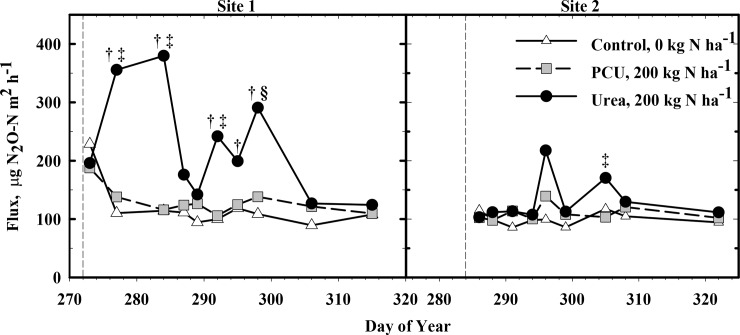
Nitrous oxide (N2O) flux measured on multiple individual days for Sites 1 and 2 from application of 0 (Control) and 200 kg N ha-1 polymer coated urea (PCU) or urea.Significance for comparing fertilizer source on a given day is indicated by † (urea greater than control), ‡ (urea greater than PCU), and § (PCU greater than control). Vertical dashed lines indicate date of fertilizer application at a given site.